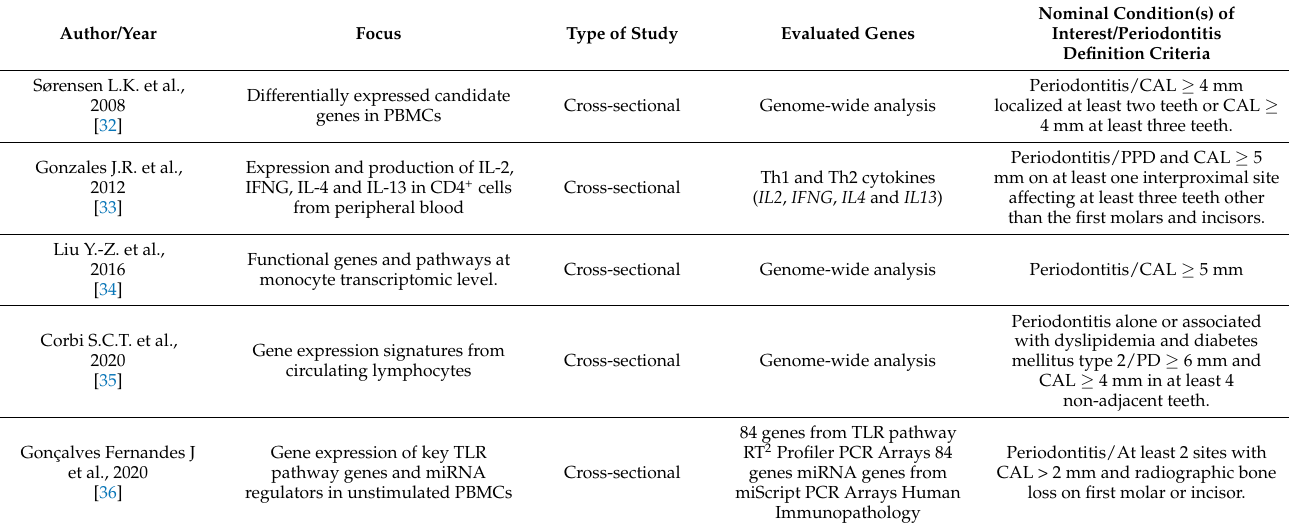
Table 4. Studies assessing Peripheral blood mononuclear cells (PBMCs) or subcomponents (lympho- cytes and monocytes) differential gene